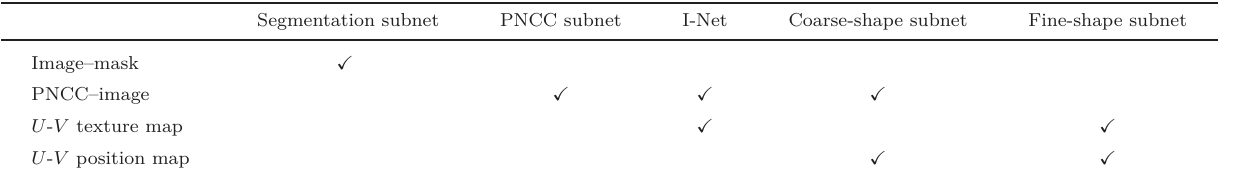
Table 1 Training data for different modules in